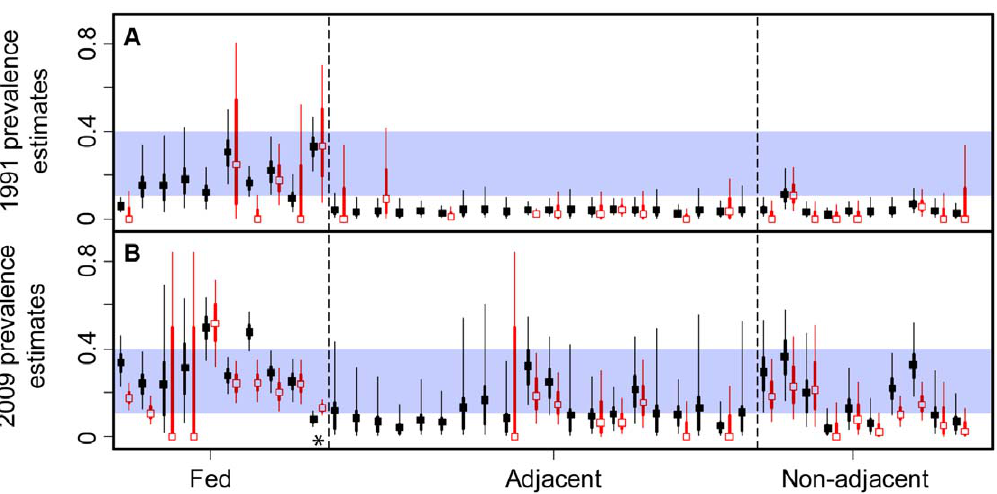
Figure 4. A comparison of model-based and raw data estimates of brucellosis seroprevalence among adult female elk. Model estimates for 1991 (A) and 2009 (B) were based on the means of the predictive posterior distributions from Model 1 (black). Raw estimates were based on data from 1991–1994 (A) and 2006–2009 (B; red, offset to the right). Lines refer to the credibility and confidence intervals for the model and empirical estimates, respectively (wide lines =[25–75], thin lines =[2.5–97.5]). Fed areas were regions that included a supplemental elk feeding grounds. Adjacent areas shared a boundary with fed areas. Non-adjacent areas did not share a boundary with areas with feedgrounds. Model estimates were standardized by assuming all samples were from research captures. The asterisk marks the test-and-remove region and the empirical estimate was based only on 2009 data for that site. The blue rectangle highlights the range of seroprevalence estimates of fed regions in 1991, which included some regions without feedgrounds in 2009.